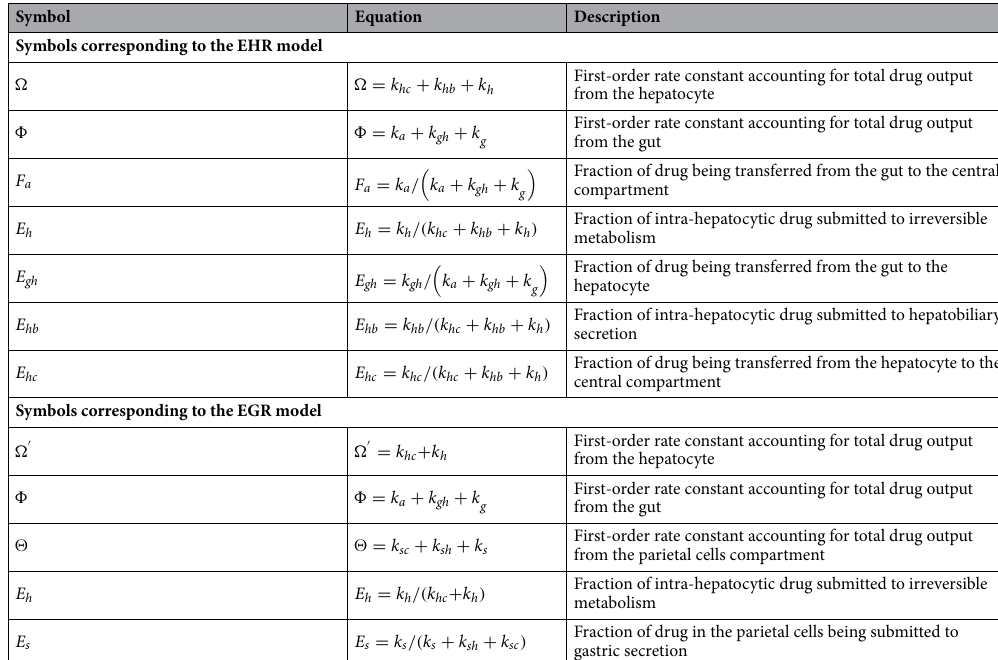
Table 1. Symbols implemented for deriving theoretical equations of pharmacokinetic parameters. First- order rate constants describing mass transferences: k a (drug absorption from the gut into the central compartment), k gh (hepatic uptake of drug coming from the gut through portal venous blood), k g (intestinal elimination), k cg (drug transference from the systemic circulation to the gut), k hc (drug transference from the hepatocyte to the central compartment), k ch (drug transference from the central compartment to the hepatocyte), k h (hepatic elimination), k hb (hepatobiliary secretion), k cs (drug transference from the central compartment to the parietal cells), k sc (drug transference from the parietal cells to the central compartment), k s (drug secretion from parietal cells into gastric lumen) and k sh (hepatic uptake of drug coming from the parietal cells through the gastric